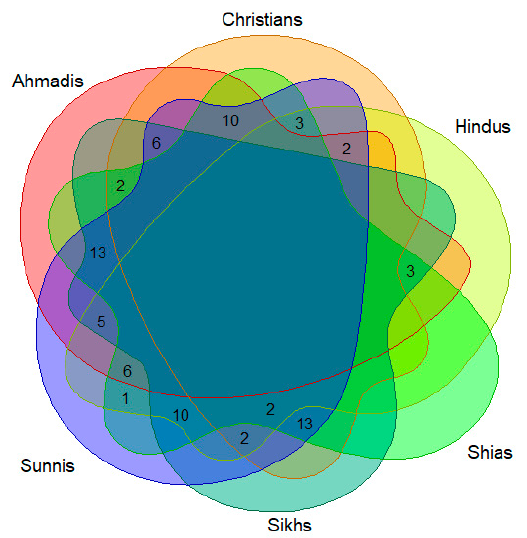
Figure 6. Venn diagram showing the overlaps of the recorded wild food plants among the six considered groups.